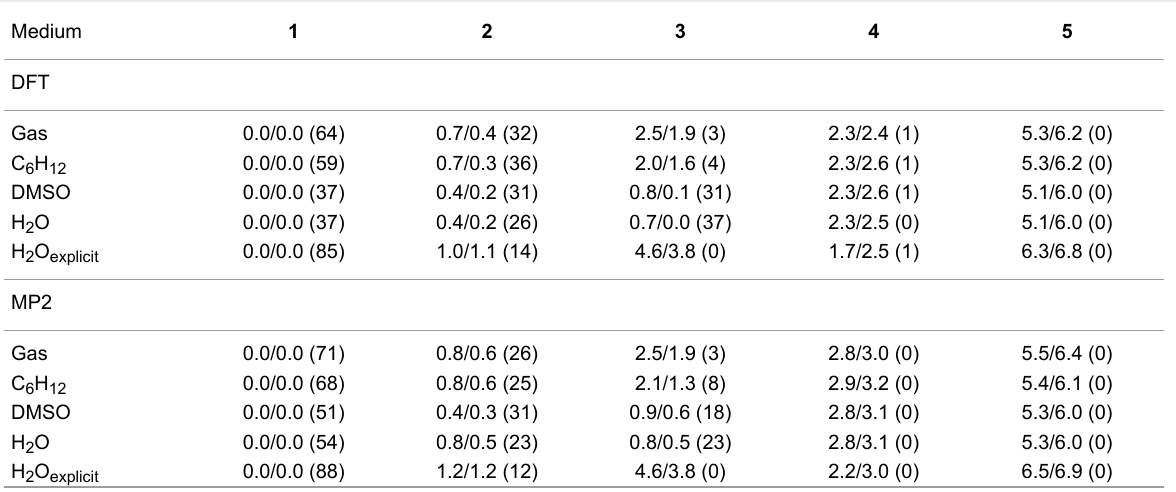
Table 1: Relative electronic/Gibbs free energies (kcal mol − 1 , % Gibbs population in parenthesis) for the conformers of isoflurane. a